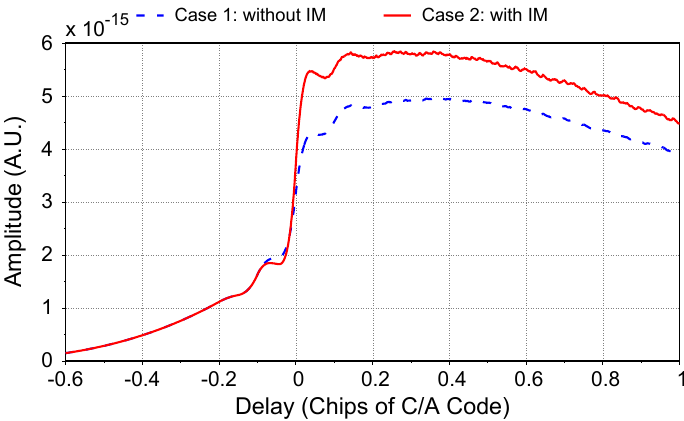
Figure 5. Modelled L1 reflected power waveform for the spaceborne scenario in Table 2 with and without considering the IM component. Case 1: GPS L1 without the IM component, Case 2: GPS L1 with the IM